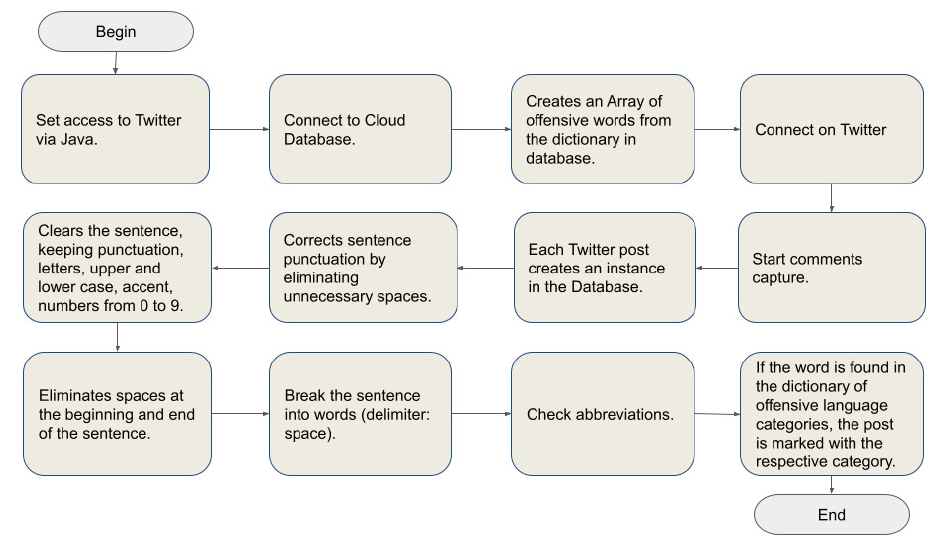
Figure 6. Flow to collect post from Twitter that could contain offensive language.